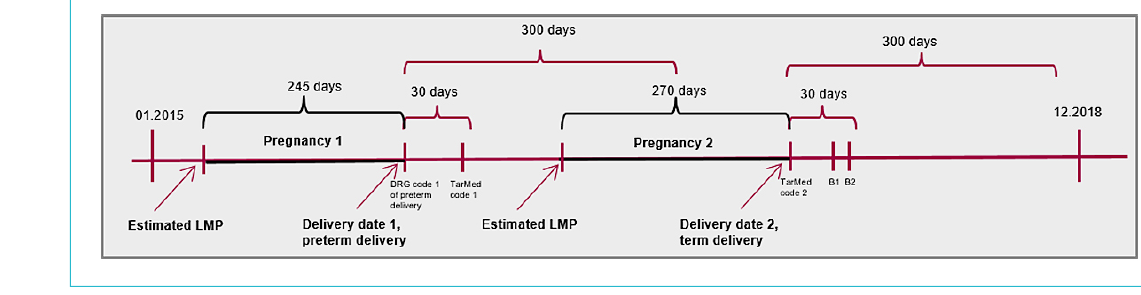
Figure 1: Definition of delivery and last menstruation period (LMP)